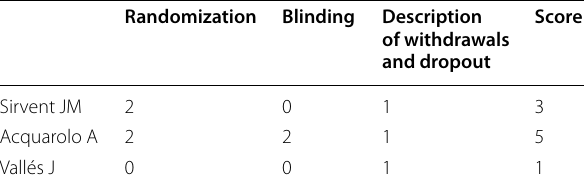
Table 2 Summary of the quality evaluation by Jadad Scale of clinical trials of antibiotic prophylaxis in comatose patients